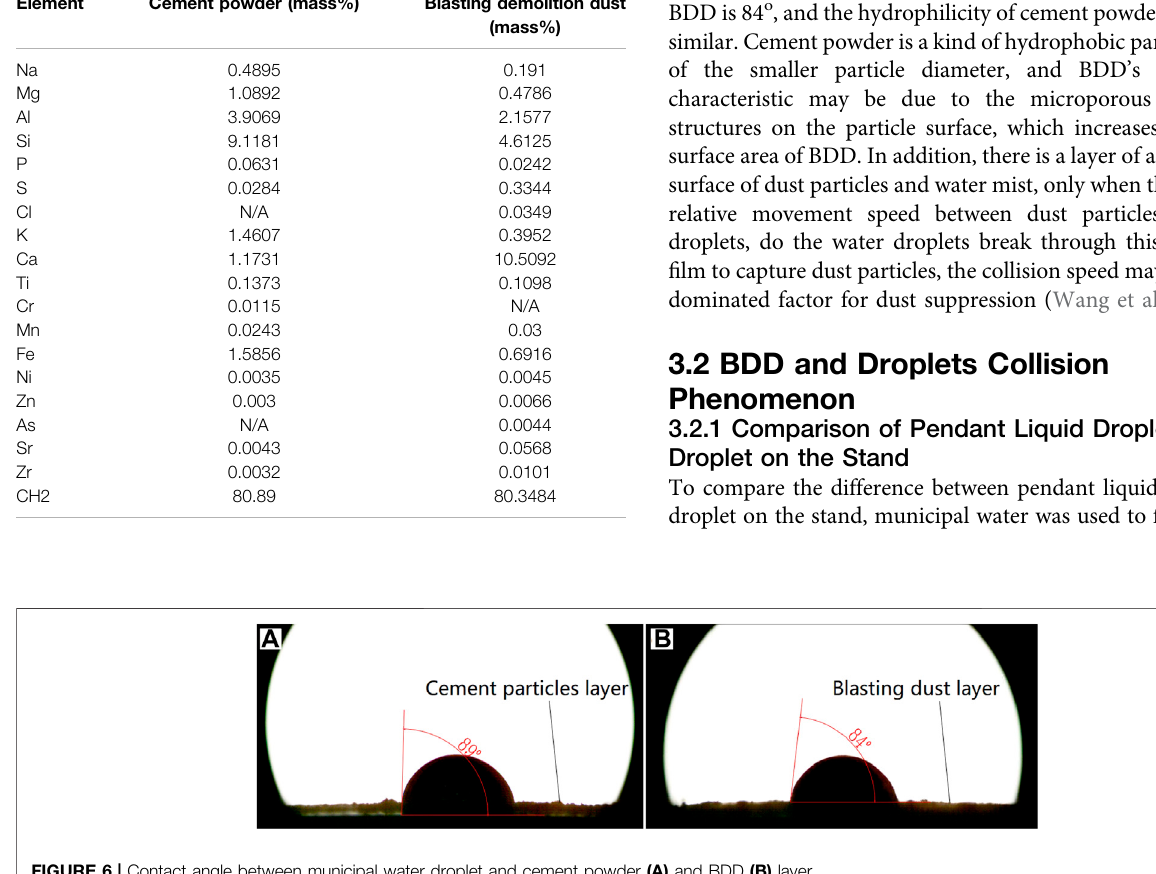
Frontiers in Environmental Science |